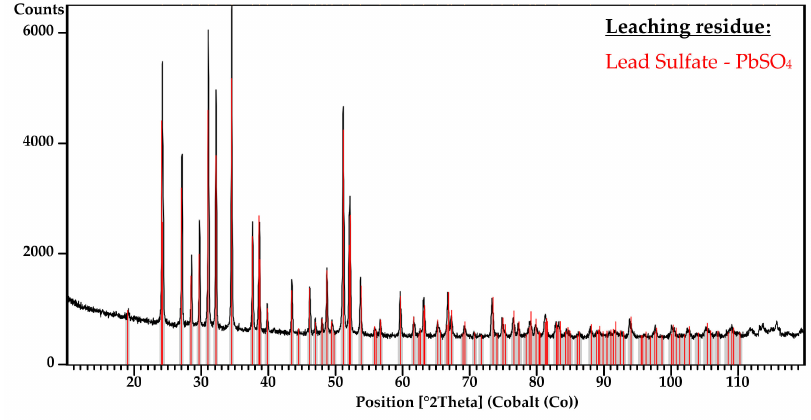
Figure 7. XRD analysis of CAF dust leaching